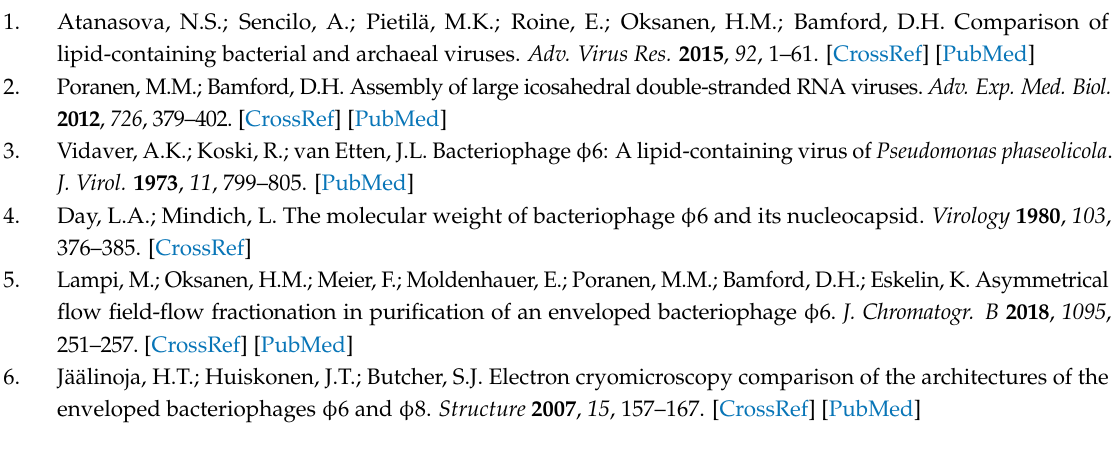
backgrounds; Figure S3: φ 6 retention in AF4; Figure S4: φ 6 RNA retention in AF4; Figure S5: Refractionation and AF4 fractionation of purified φ 6 NC; Figure S6: Purification of φ 6 NC by AF4; Figure S7: Capacity of AF4-purified φ 6 NC to infect spheroplasts. Author Contributions: K.E. designed and performed the experiments. K.E. and M.M.P. wrote the